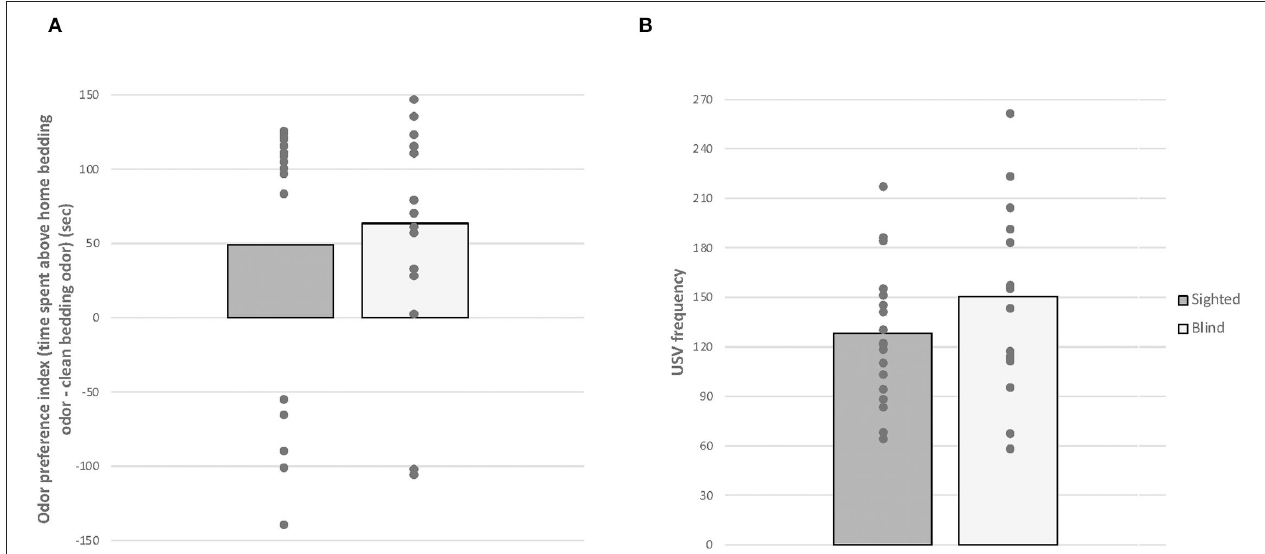
FIGURE 4 | Home odor discrimination and preference test. Anophthalmic and sighted mice assayed to the home odor discrimination and preference test: (A) Time spent (s) exploring the home bedding odor minus the clean bedding odor and (B) total numbers of USVs produced by PND 7 pups during the 2-min test (mean ± SE).